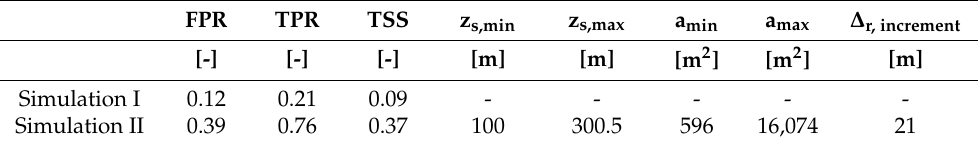
Table 4. Ultimate values of the objective functions FPR and TPR in Simulations I and II and cor- responding responses of the true skill statistic (TSS). Optimized values of the slip-surfaces search parameters for SCOOPS 3D are also